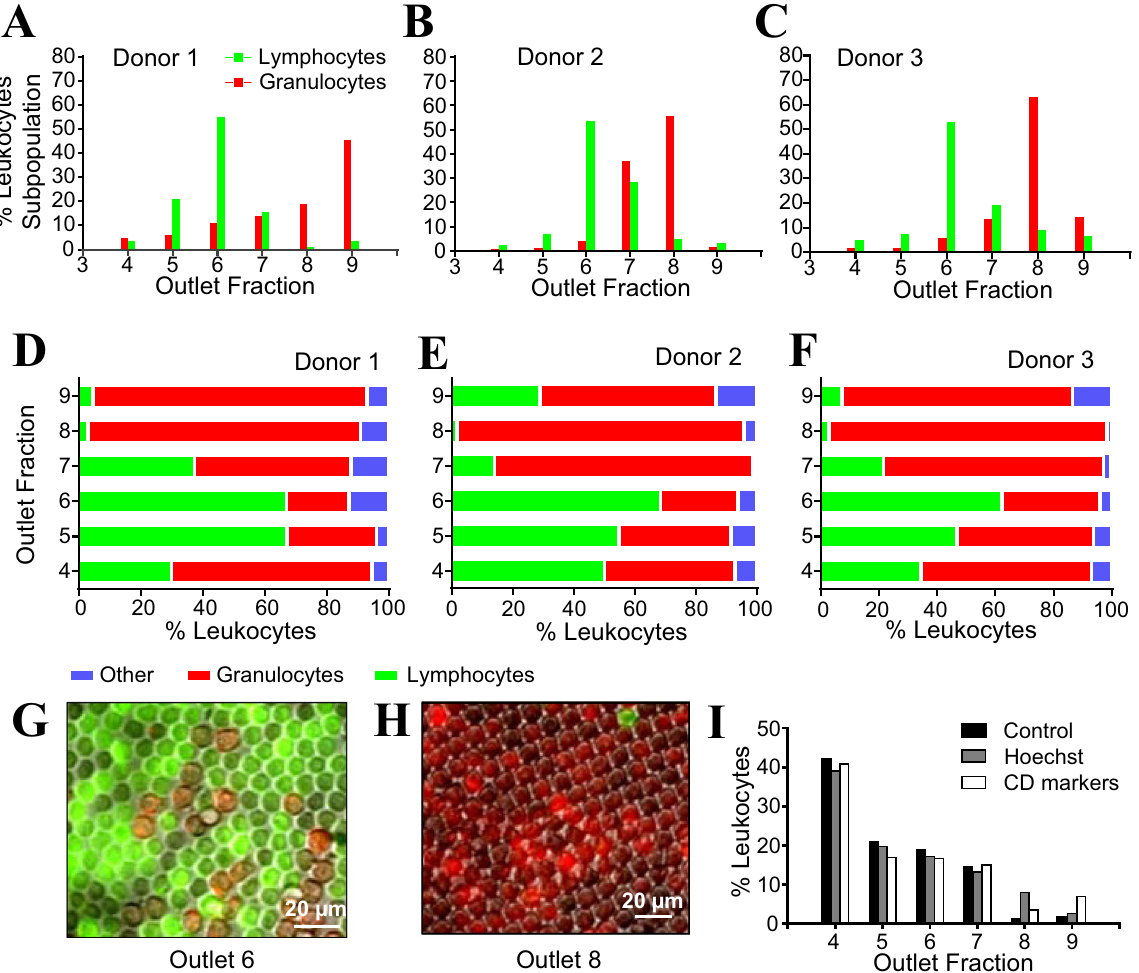
Figure 5. Separation of lymphocytes and granulocytes from whole blood. ( A – C ) Deformability profiles of lymphocytes and granulocytes enriched from blood of three different donors. ( D – F ) Relative abundance of lymphocytes and granulocytes in each outlet. ( G , H ) Images of the immunostained lymphocytes (green) in O6 and granulocytes (red) in O8. ( I ) Comparison of distributions of leukocytes in O4–9 of three different samples: (1) whole blood without stain, (2) with Hoechst 33342 and (3) with anti-CD markers conjugated with fluorescence